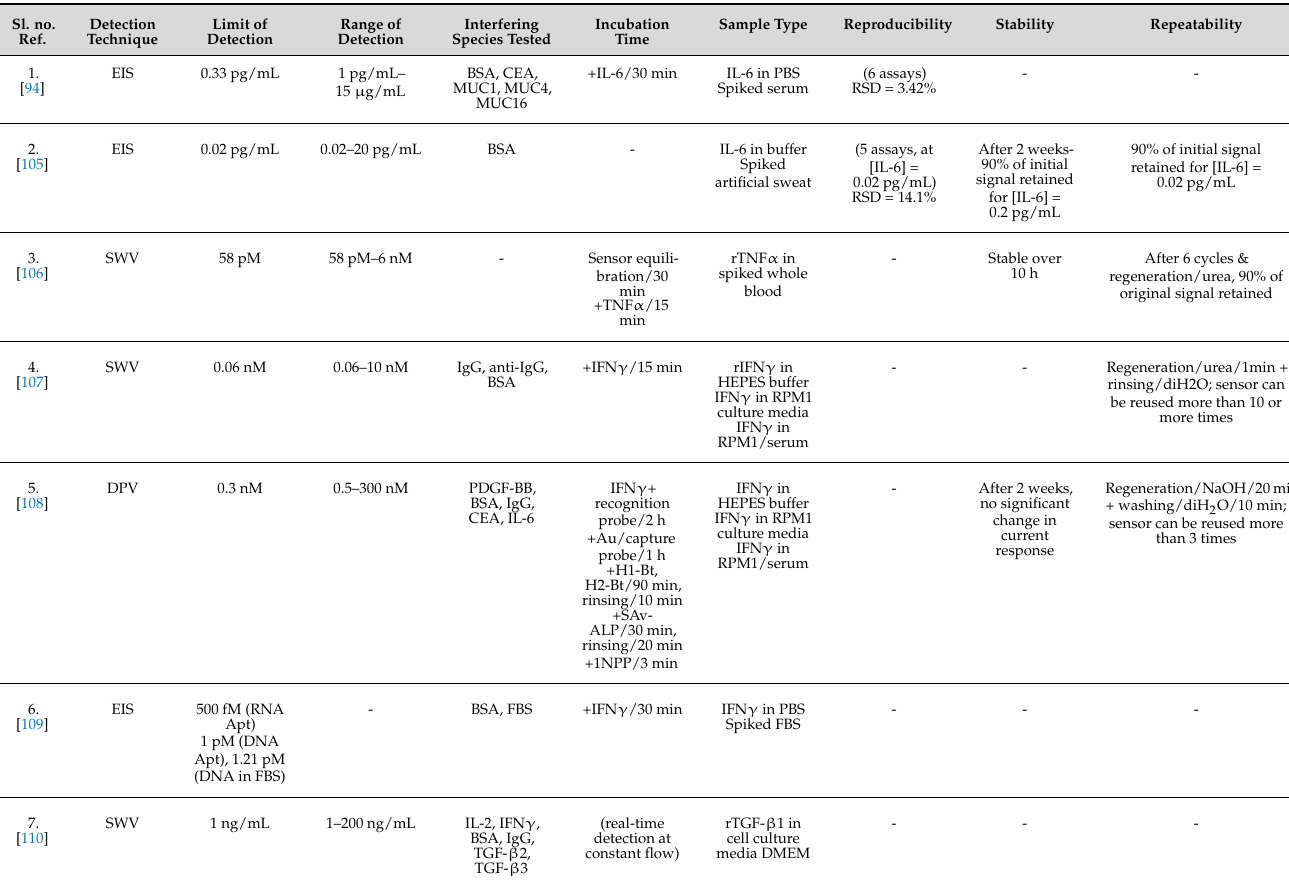
Table 2. Aptasensors: Specifications and performance